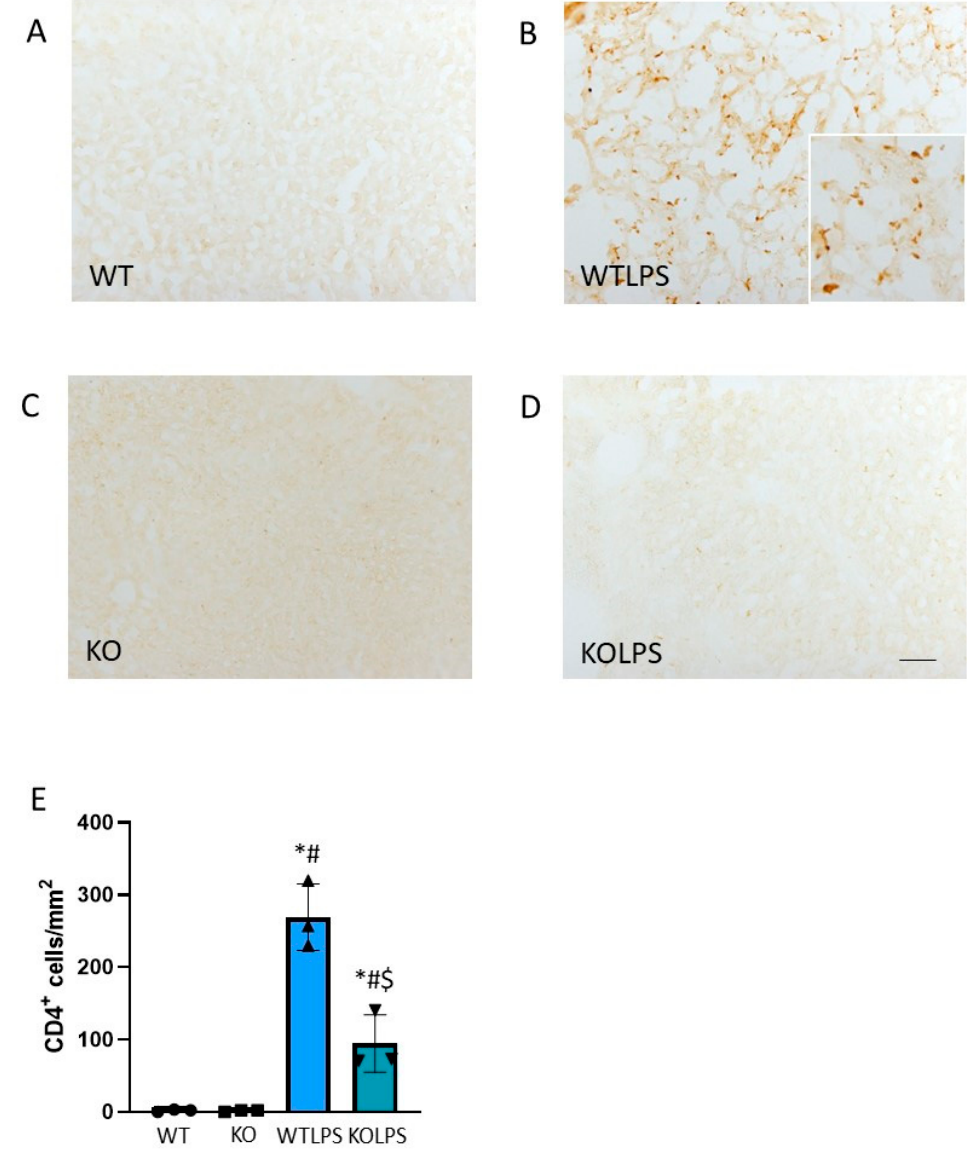
Figure 8. CD4 expression in liver. Representative immunostaining from sections of the different treatments assayed. WT ( A ) and KO ( C ) animals show a normal pattern of CD4 expression; however, the treatment with LPS produces a strong induction of CD4-positive cells in WT animals ( B ). Absence of Gal3 clearly reduces this effect ( D ). Scale bar: 100 μ m. ( E ) Quantification of the density of CD4 positive cells in liver. Results are mean ± SD of N = 3 animals, expressed as number of cells per mm2. Statistical significance (one-way ANOVA followed by the LSD post hoc test for multiple comparisons): * -compared with WT group; # -compared with KO group; $ -compared with WTLPS group; p < 0.001. Abbreviations: WT, wild type mice; WTLPS, wild type mice treated with LPS; KO, Gal3 knockout mice; KOLPS, Gal3 knockout mice treated.